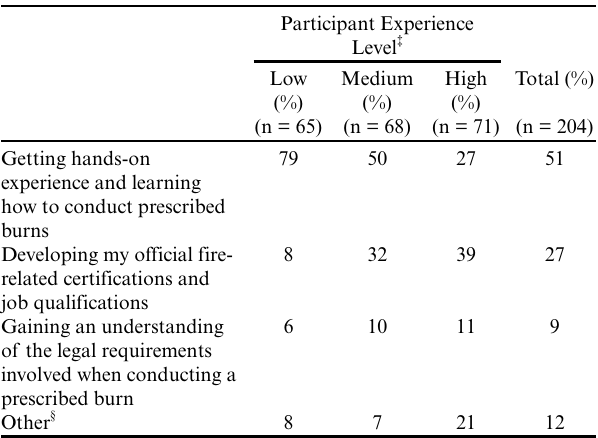
Table 4 . Reported motivation for attending a Prescribed Fire Training Exchange event, comparing experience levels.